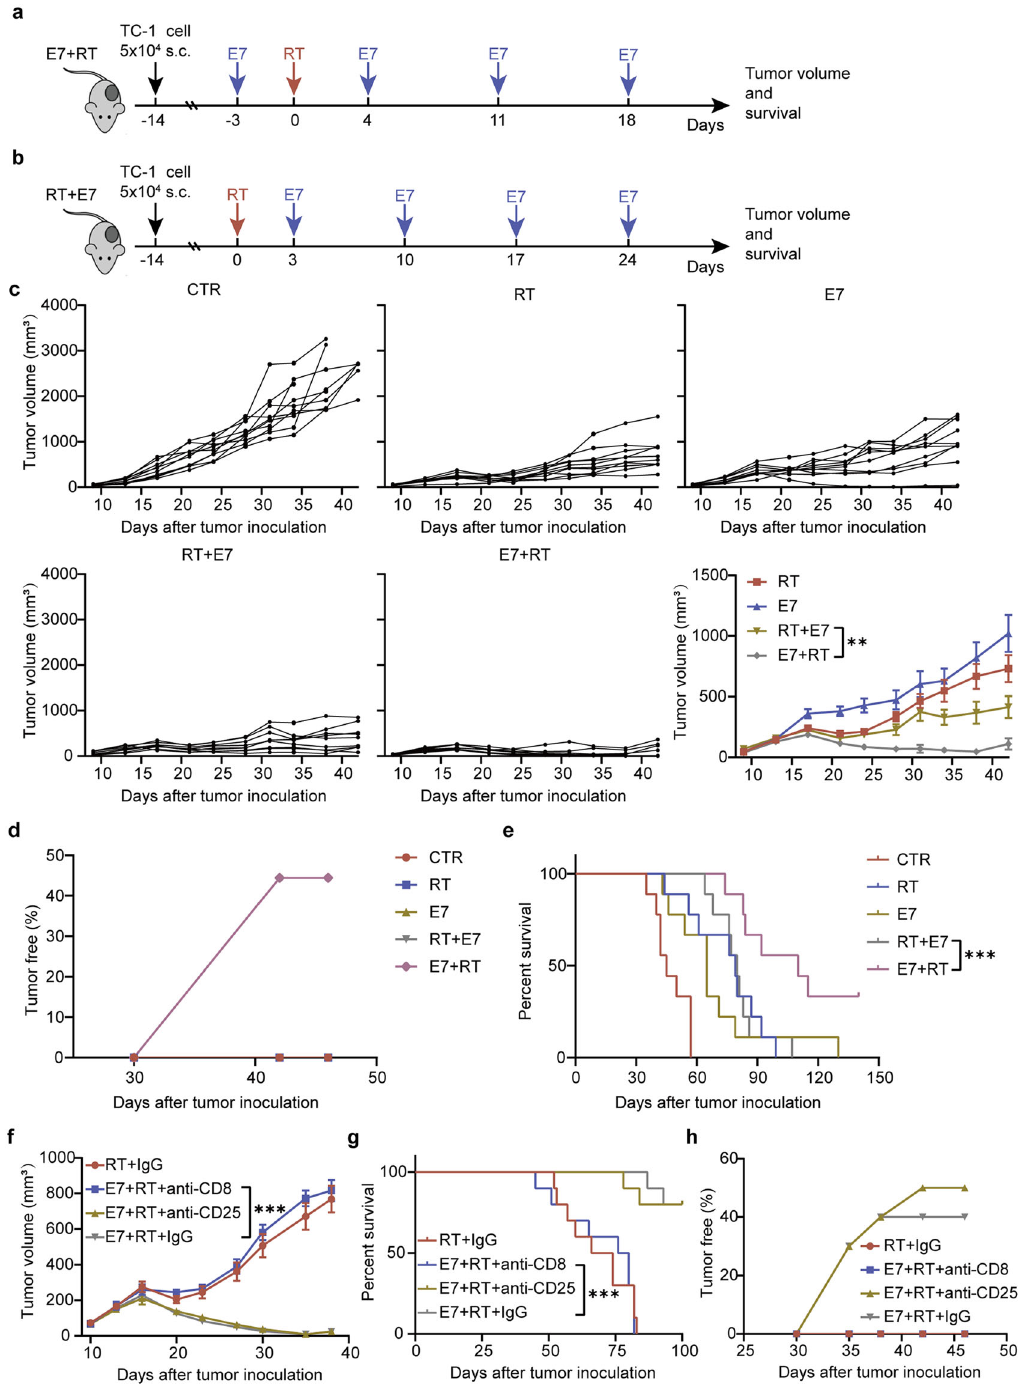
Fig. 6 Sequences of vaccine administration and tumor irradiation were crucial to produce durable antitumor effects. a , b Experimental procedures. a Vaccination followed by RT (E7 + RT): tumor-bearing mice received the fi rst dose of E7 vaccine (5 μ g per mouse) after tumor cells injection for 11 days, then the tumors were irradiated on day 14, another three doses of E7 vaccines were administrated subcutaneously (sc.) on days 4, 11, and 18 after RT. b RT followed by vaccination ( RT + E7 ): tumors were irradiated with single dose of radiation on day 14 after tumor cells injection and then followed by four doses of E7 vaccines sc. on days 3, 10, 17, and 24 after RT. c Individual tumor growth curves and average tumor volumes with time, untreated tumor- bearing mice as control (CTR), 9 mice for each treatment. Tumors isolated from mice after treatment on day 14 were photographed as 4 – 5 mice for each treatment. d Percentage of the tumor-free mice that received with different treatments, only E7 + RT treatment showed 4 mice with tumor rejection. e Survival curves of the TC-1 tumor-bearing mice with various treatments. f Depleting experiments with antibodies. Tumor-bearing mice treated by E7 + RT with anti-CD25 (10 doses, 200 μ g/mouse) or anti CD8 (3 doses, 200 μ g/mouse) antibodies, IgG as control, for details, see the Methods and the schematic shown in Fig. 2h. g The percentages of mice survival and h the tumor-free mice followed various treatments, 10 mice for each treatment. Results are presented as mean ± SD. Experiments were repeated two times and two-tailed t -test was used for two-way comparisons of biological replicates. * P < 0.05, ** P < 0.01, *** P < 0.001, **** P <